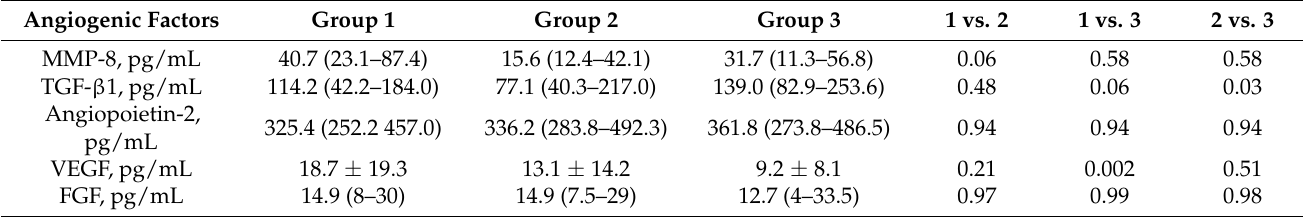
Table 3. Plasma levels of angiogenic factors in patients with coronary artery abnormal dilation (CAAD, Group 1) in comparison to patients with obstructive coronary artery disease (Group 2), and controls with normal coronary arteries (Group